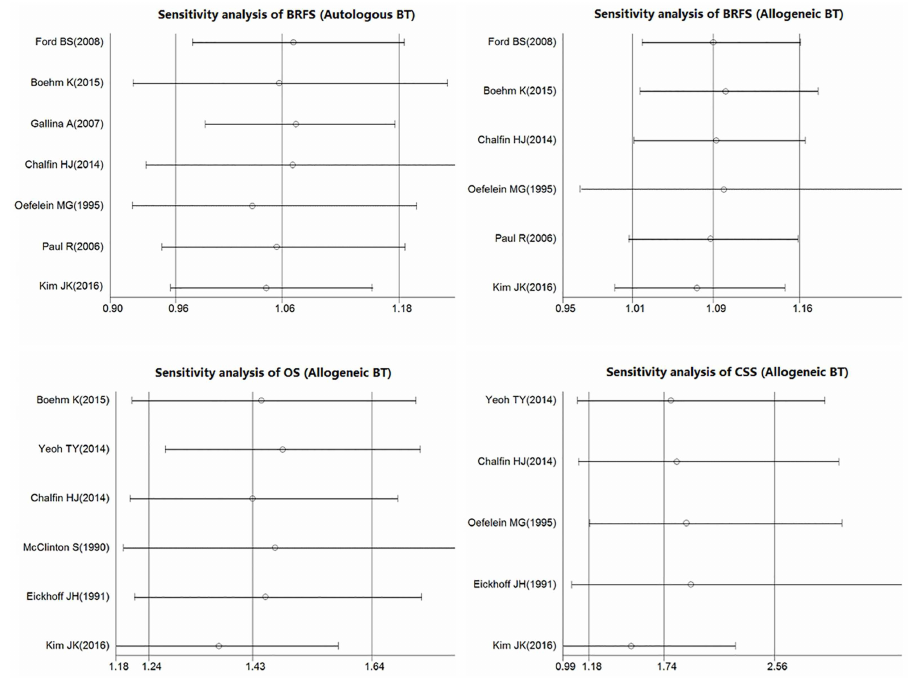
Fig 4. Results of the sensitivity analysis.